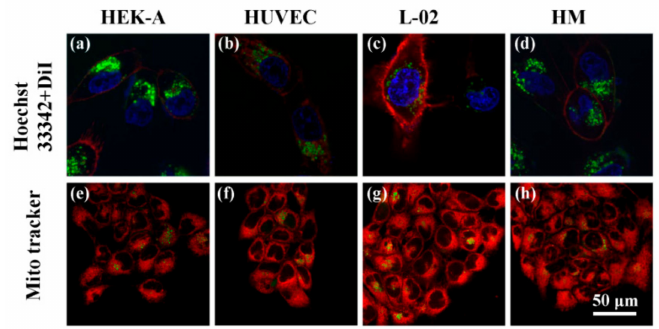
Figure 8. Intracellular localizations of fluorescein-labeled C 60 -PDA-GSH nanoparticles in ( a , e ) HEK-a, ( b , f ) HUVEC, ( c , g ) HM, and ( d , h ) L-02 cells, separately. After 3 h of co-incubation, cells were fixed and analyzed by confocal microscopy. Green fluorescence represents C 60 -PDA-GSH nanoparticles, red fluorescence displays DiI-stained cell membrane, blue fluorescence indicates Hoechst 33342-stained nuclei, and deep red fluorescence illustrates MitoTracker-stained mitochondria.